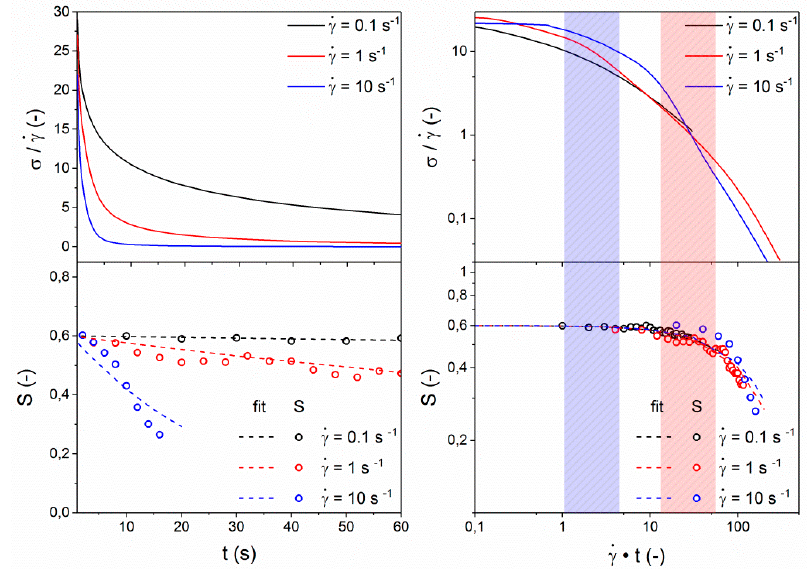
Figure 9. Relaxation of the investigated LCP after cessation of shear. Shear was applied at 150 °C for at least 200 s.u. The data on the left depict the normalized shear stress ( top ) and orientation parameter ( bottom ) as a function of time, whereas the figures on the right depict the same signals after normalization of the x -axis to γ(cid:4662) ∙ t . The area marked in blue indicates a 50% decrease in shear stress, and the area marked in red indicates the onset of the decrease in orientation parameter.